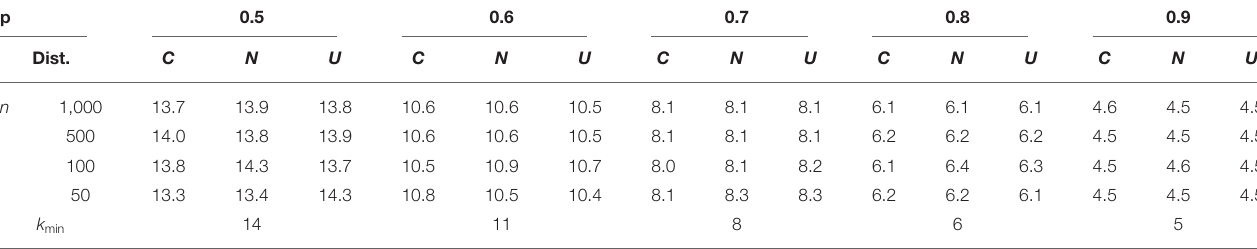
TABLE 5 | The numbers of repeated examination ˆ k min for p i ≡ p , p i ∼ N ( p ,0.3 2 ) and p i ∼ U ( p − 0.3, p +